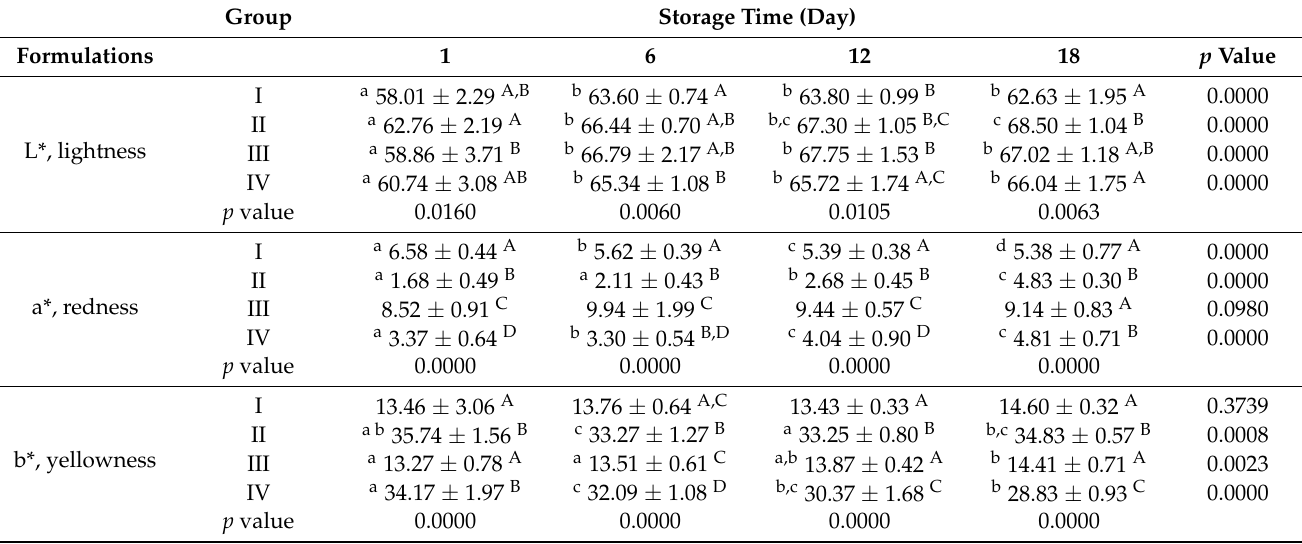
Table 3. Effect of turmeric addition and storage time on colour on the cross section of duck burgers during